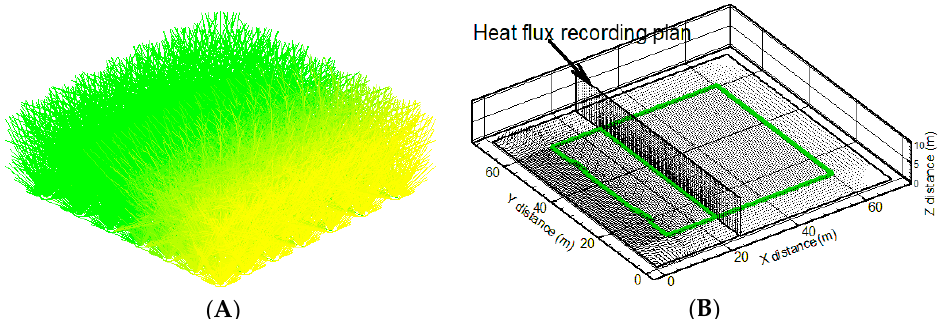
Figure 2. Presentation of the numerical fuel bed model and the computational domain: ( A ) Modelling of a grass layer with a load of 0.6 kg·m − 2 and a height of 0.29 m; ( B ) Computational domain and plan for heat flux recording. The wind speed field is in black, and the limits of the fuel layer are in green.